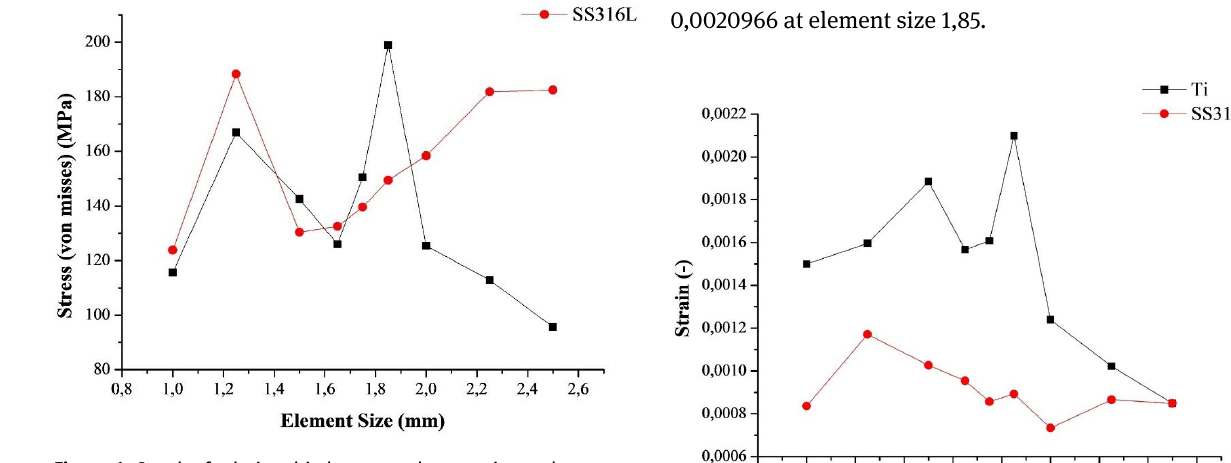
Figure 6: Graph of relationship between element size and stress (von misses) Ti-6Al-4V and SS 316 L.